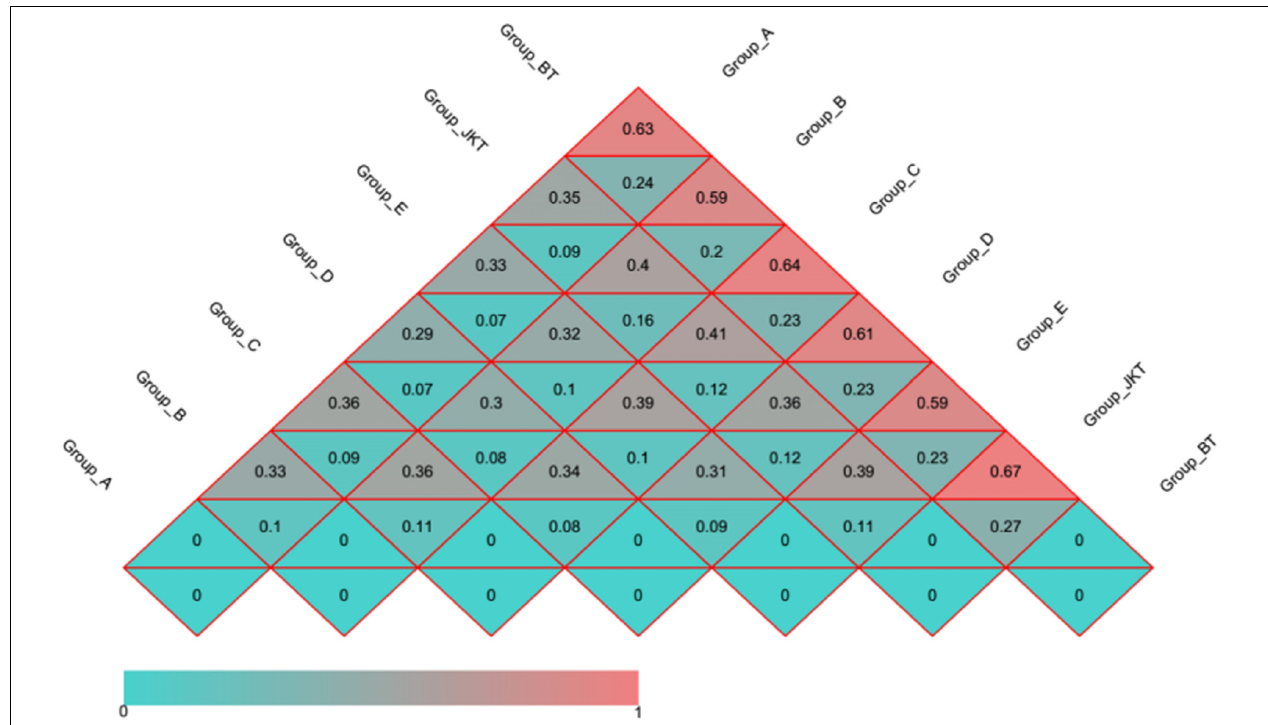
FIGURE 4 | Distance heatmap graph of seven soil samples. Weighted UniFrac and unweighted UniFrac analysis. The number in the grid is the coefficient of dissimilarity between two samples. The smaller the coefficient of dissimilarity, the smaller the diversity of species. In the same grid, the upper and lower values represent the distance between unweighted UniFrac and weighted UniFrac,